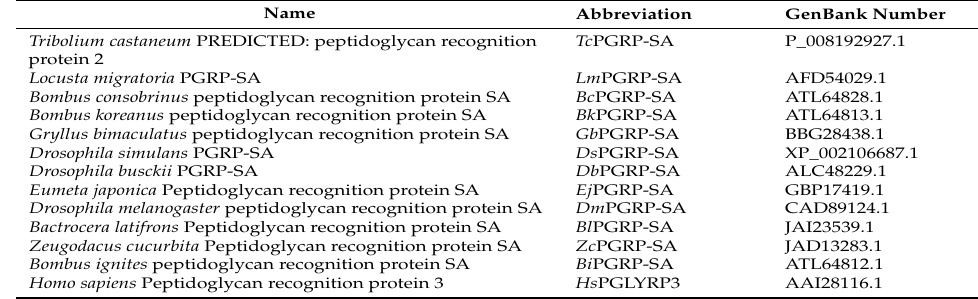
Table 1. The accession number of PGRP-SA proteins used for bioinformatic analysis of this study. Name Abbreviation Tribolium castaneum PREDICTED: peptidoglycan recognition protein